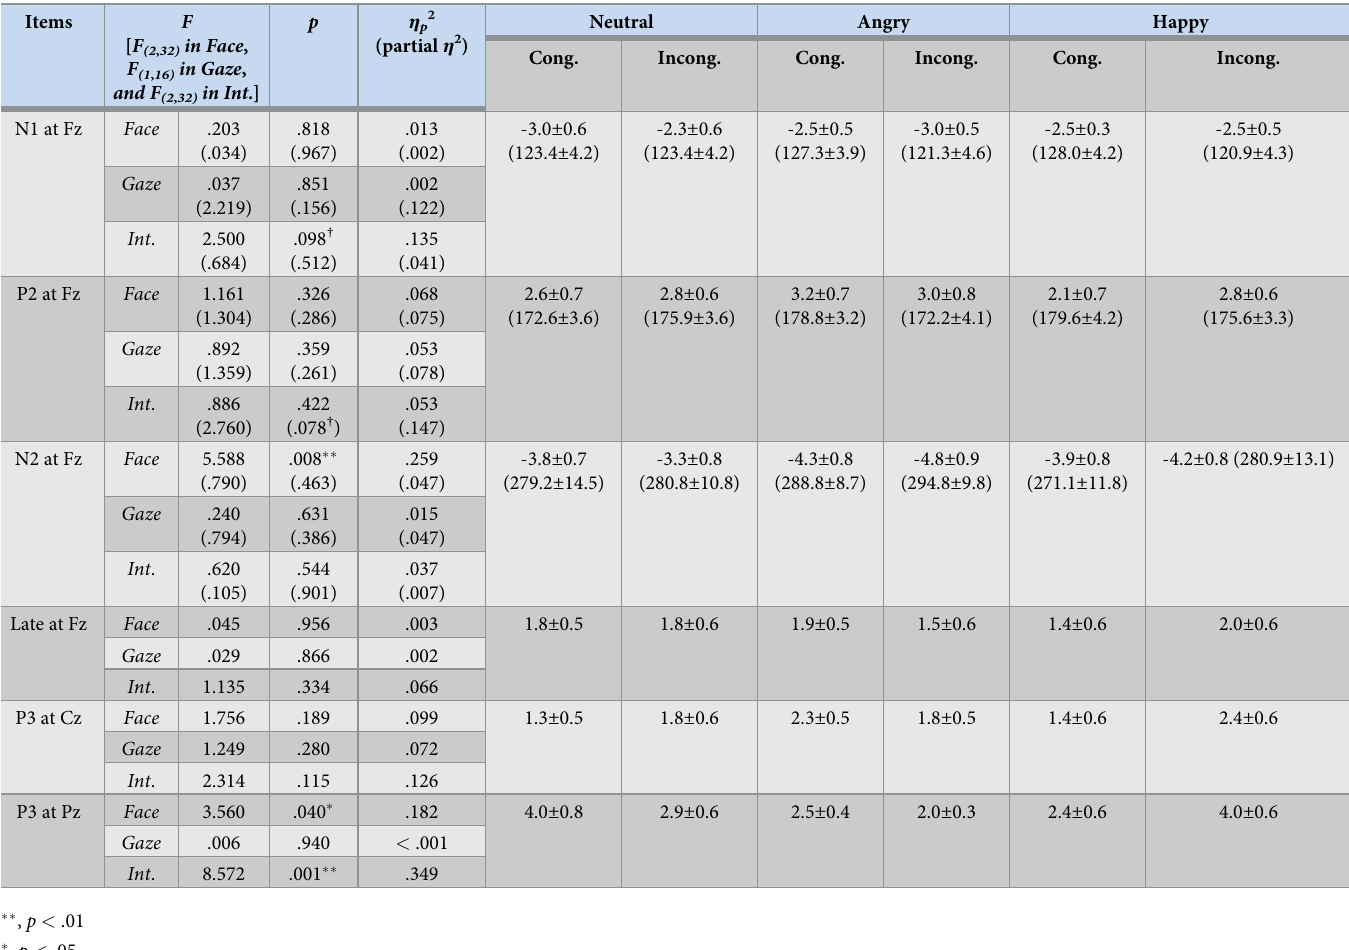
Table 3. ERPs ( μ V) during the working memory task for young adults. Items F [ F , (2 , 32) in Face F (1 , 16) in Gaze , and F (2 , 32) in Int .]